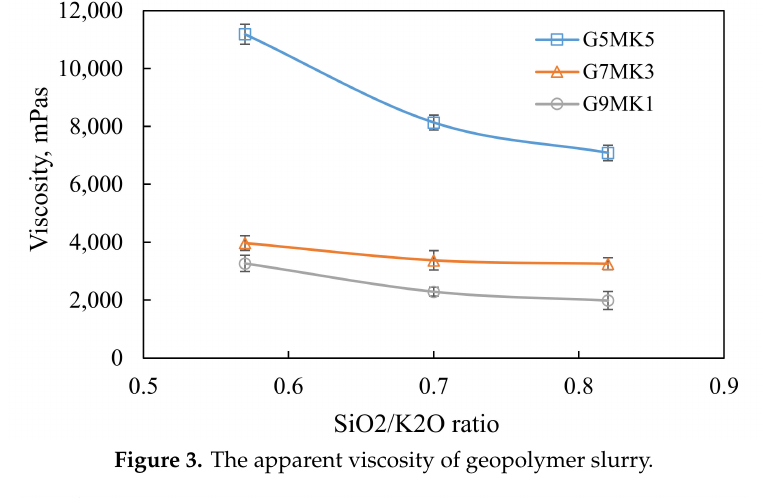
Figure 3. The apparent viscosity of geopolymer slurry.